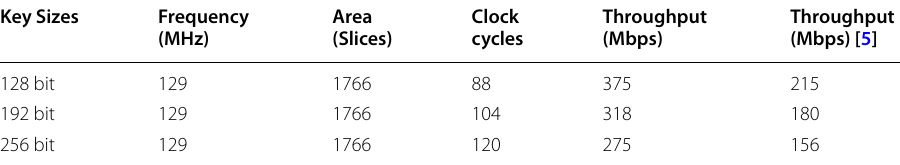
Table 4 Design synthesis results and performance comparison Key